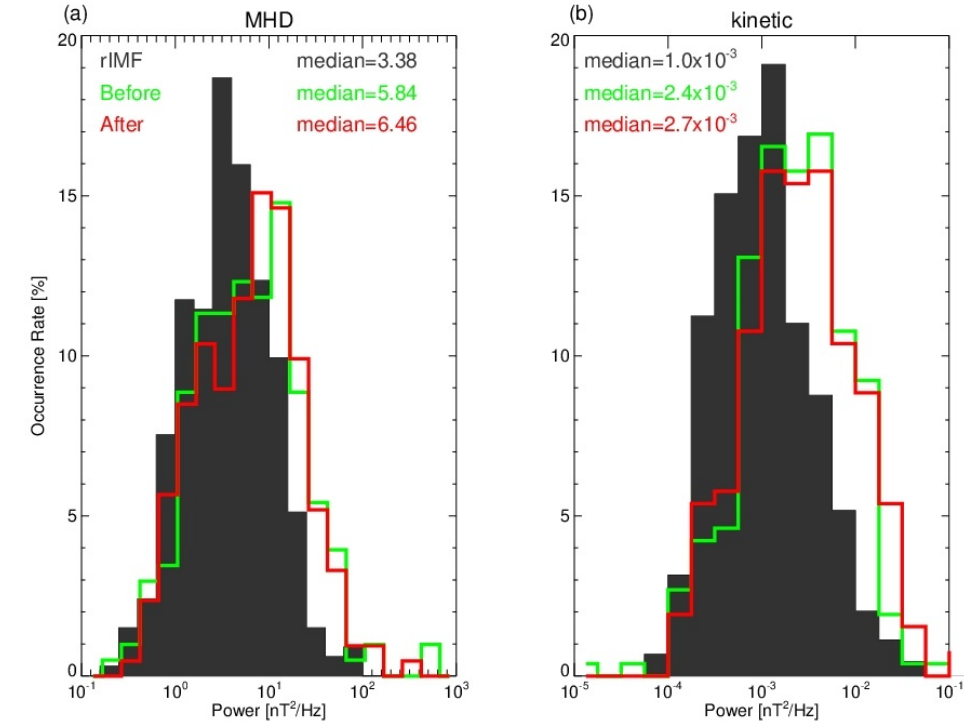
Figure 5. Histograms of the PSD powers in ( a ) the MHD and ( b ) kinetic ranges. The format and colors are the same as in Figure 4.